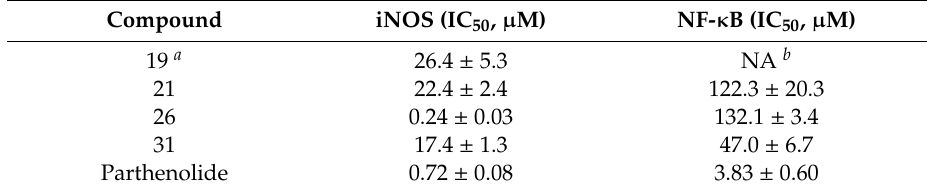
Table 2. In vitro anti-inflammatory activities of compounds 19 , 21 , 26 , and 31 .